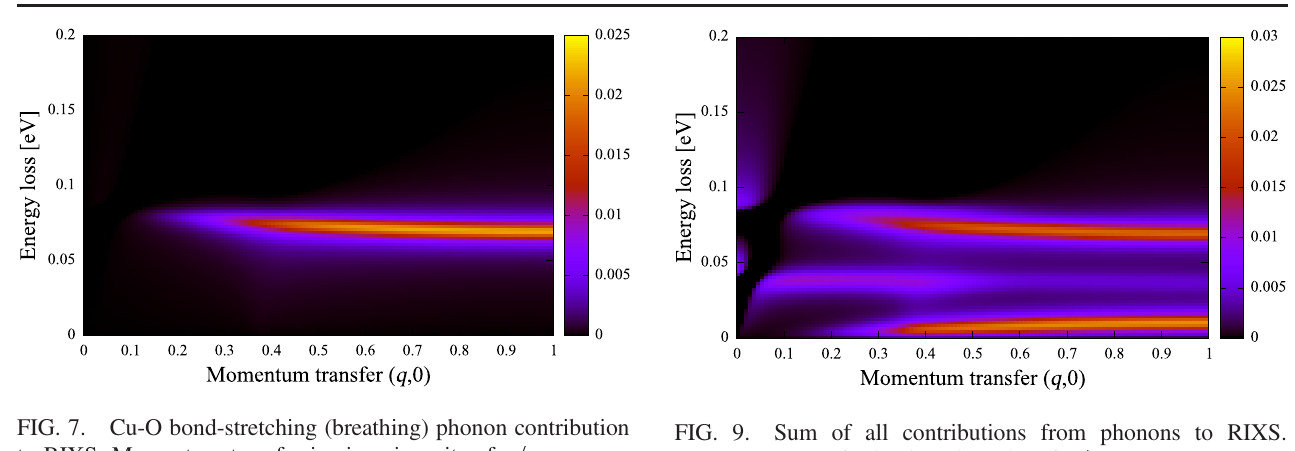
FIG. 9. Sum of all contributions from phonons to RIXS. Momentum transfer is given in units of π =a